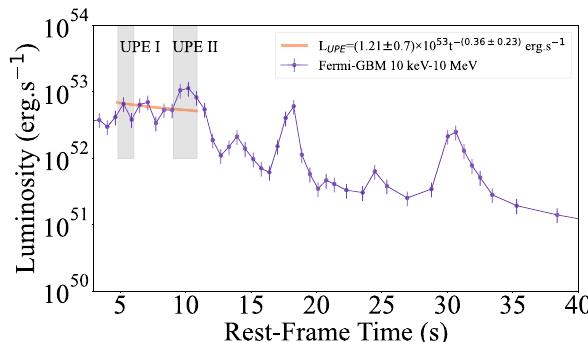
Fig. 6 NS critical mass as a function of the spin parameter α for the NL3 and TM1 EOS. We recall that the maximum spin parameter of a uniformly rotating NS is α max ≈ 0 . 71, independently of the NS EOS; see e.g. Cipolletta et al. [15] nates from BH extractable energy, i.e.